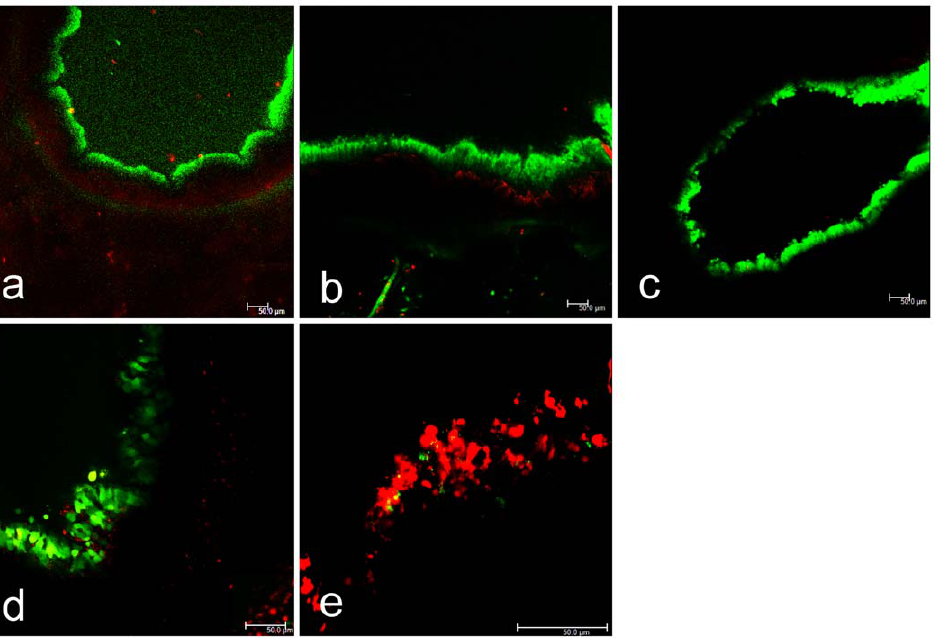
Figure 1. Vitality of PCLS evaluated by live (green)/dead (red) staining. Slices were stained with a commercial kit at day 1, 3 and 7 after preparation (upper panels, a–c). For comparison, in the lower panels the live/dead staining is shown for two slices that either had retained full ciliary activity (100%) (d), or had completely lost ciliary activity (0%) (e). The scale bar indicates 50 m m.